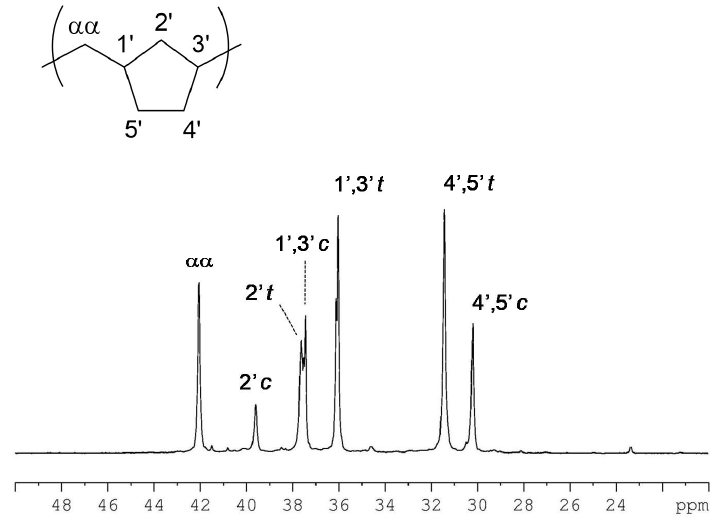
Figure 11. 13 C NMR spectrum (108.58 MHz, C 2 D 2 Cl 4 , 103 °C) of poly(HED) sample prepared by 5/ MAO catalytic system.